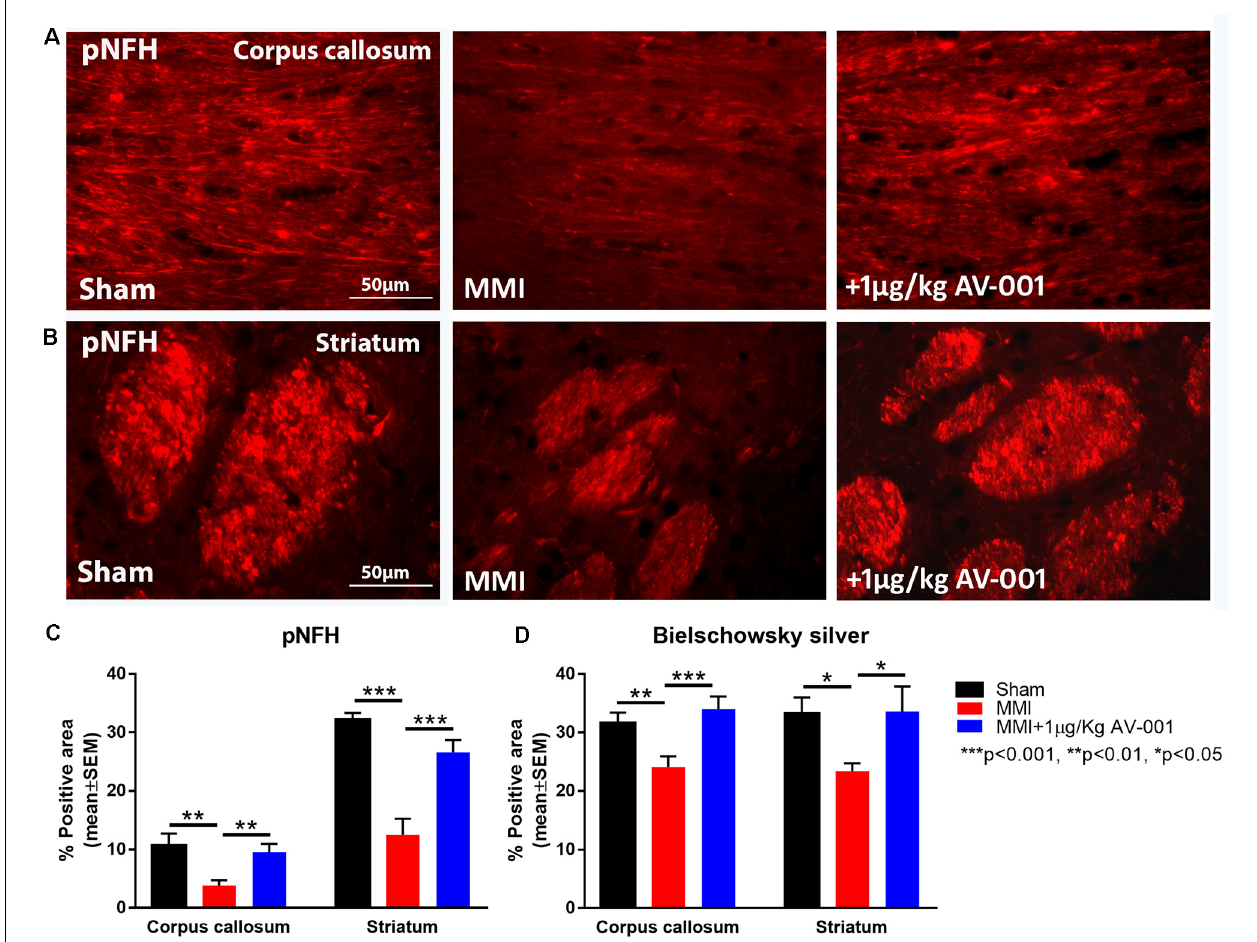
FIGURE 4 | AV-001 treatment significantly improves axonal/white matter remodeling in middle-aged rats subjected to MMI. (A–C) Representative images and quantification data of pNFH staining in the Corpus callosum and Striatum. MMI induces significant axon damage in the Corpus callosum and white matter bundles of the Striatum compared to Sham control rats. Treatment with 1 µ g/Kg AV-001 significantly increases axon density in the Corpus callosum and Striatum compared to MMI rats. (D) Quantification data of Bielschowsky silver staining indicating that MMI decreases axon density compared to Sham control rats, while 1 µ g/Kg AV-001 treatment significantly increases axon density in the Corpus callosum and Striatum compared to MMI